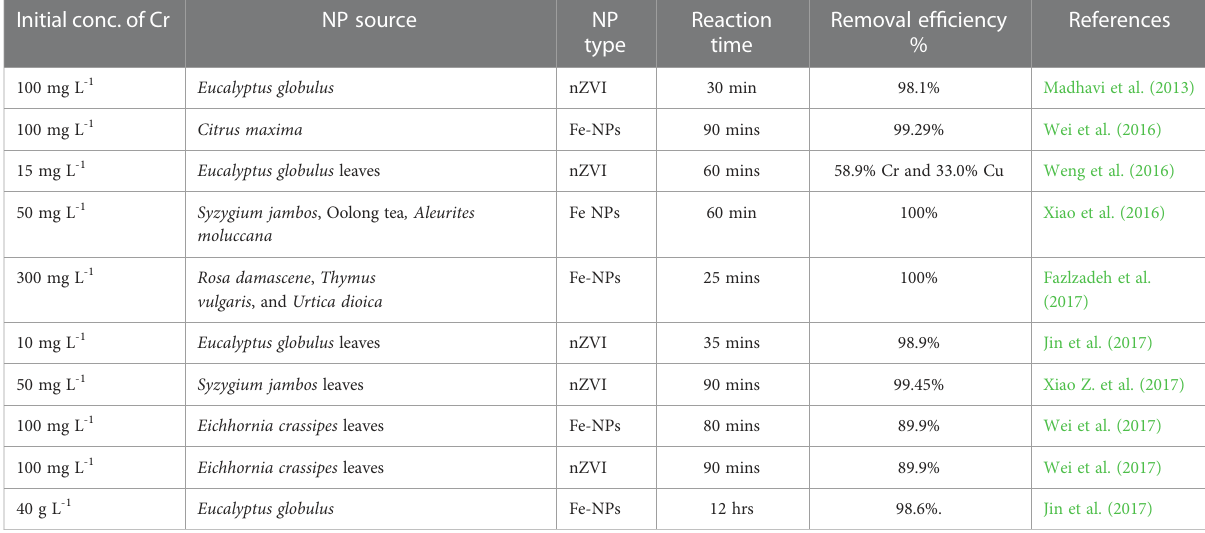
TABLE 6 Application of nanoparticles for remediation of chromium in aqueous medium. Initial conc. of